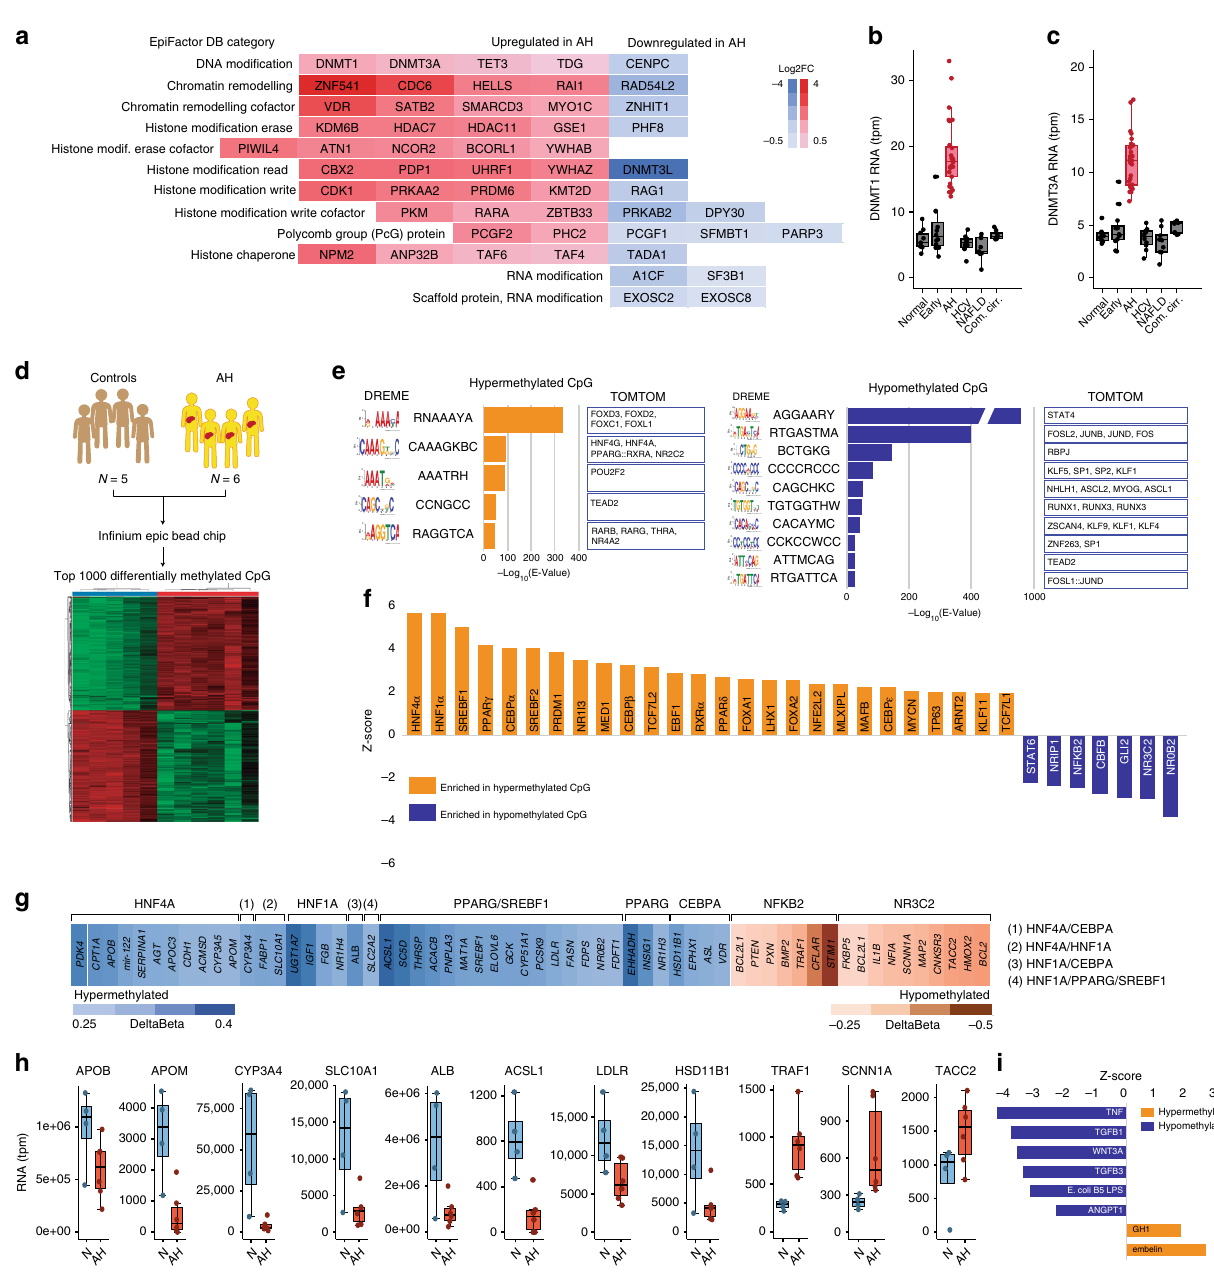
Fig. 9 DNA hypermethylation of HNF4 α -targets in AH patients. a Heatmap of Log Fold Changes in the expression of main epigenetic modulators in AH patients. Genes are organized by the 12 family of factors described in EpiFactor Database. b , c mRNA abundance in transcripts per million (tpm) from normal livers, AH livers and livers of non-alcohol-related chronic disease of b DNA Methyl-Transferases DNMT1 and c DNMT3A . d – i DNA extracted from 5 Normal and 6 AH livers was bisul fi te treated and hybridized in Illumina In fi nium MethylationEPIC chip. d heatmap of top 2000 hyper or hypomethylated CpG islands. e DREME and TomTom algorithms (MEME-ChIP suite) were used to search for de novo transcription factor binding sites (tfbs) in hyper and hypomethylated regions and to identify transcription factors known to match these tfbs, respectively. f Differentially methylated regions were gene annotated (nearest-feature) and Ingenuity Pathway Analysis (IPA) was used to predict which transcription factor are predicted to be an upstream regulator genes with DM CpGs. Intensity of the enrichment is presented as Z-Score ( p < 0.01). g Selected TF target genes delta- β changes: values are expressed with blue-color gradient if hypermethylated and brown-color if hypomethylated. h RNA sequencing of the same samples used in methylation chip was used to validate potential functional impact of hyper/hypomethylation on gene expression. i IPA analysis of soluble factors upstream the hyper and the hypomethylated region. Intensity of the enrichment is presented as Z-Score. For box-and-whisker plots in b , c , h : perimeters, 25th – 75th percentile; midline, median. Gene expression levels are presented in transcripts per million reads